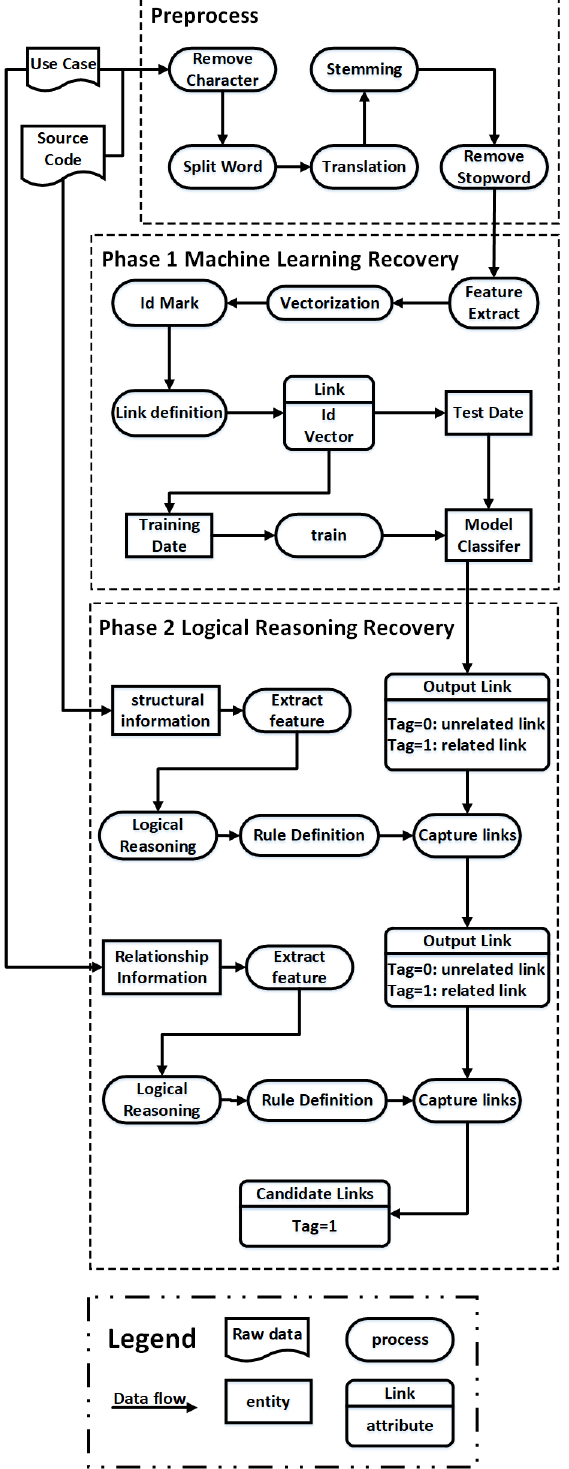
Figure 2. The analysis process of our proposed hybrid approach for recovering traceability